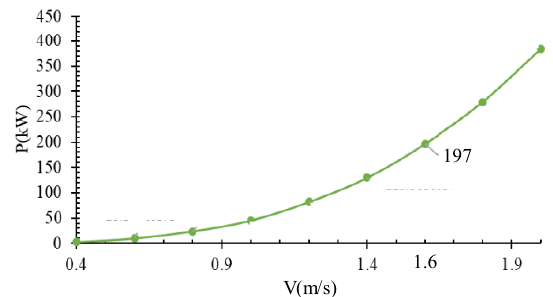
Figure 9. Relationship between CP and TSR of turbine.